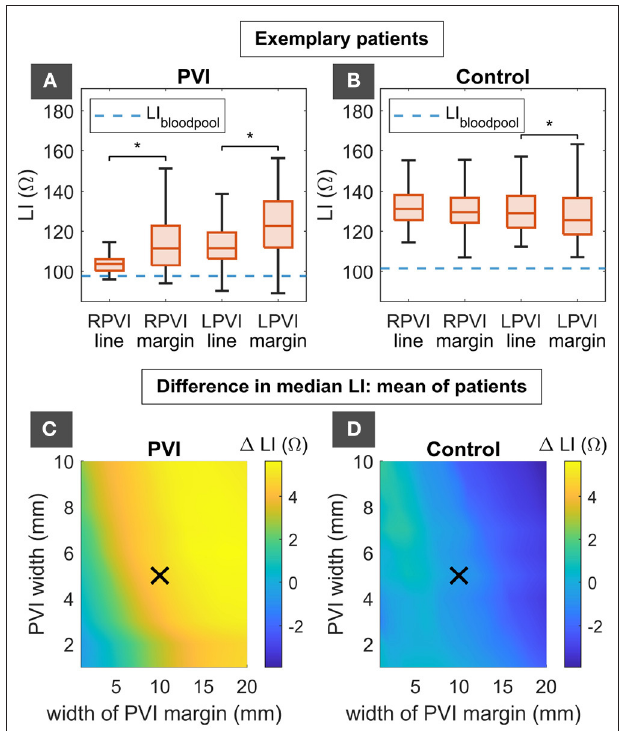
FIGURE 5 | LA in posterior-anterior perspective with color-coded bipolar voltage map (A) and LI map (B) . Left superior, left inferior, right superior, and right inferior PVs are labeled as LSPV, LIPV, RSPV, and RIPV. PVI ablation points from a previous intervention are marked by black dots. The LI map in panel (B) includes a light gray line indicating a path perpendicular to and approximately centered on the previous PVI lesion next to the LSPV. The distribution of LI measurements along this path shows a drop at the previous PVI lesion (C) . Adjacent distributions were not tested for statistical significance. LSPV, left superior pulmonary vein; LIPV, left inferior pulmonary vein; RSPV, right superior pulmonary vein; RIPV, right inferior pulmonary vein; PV, pulmonary veins; LA, left atrium; LI, local impedance.